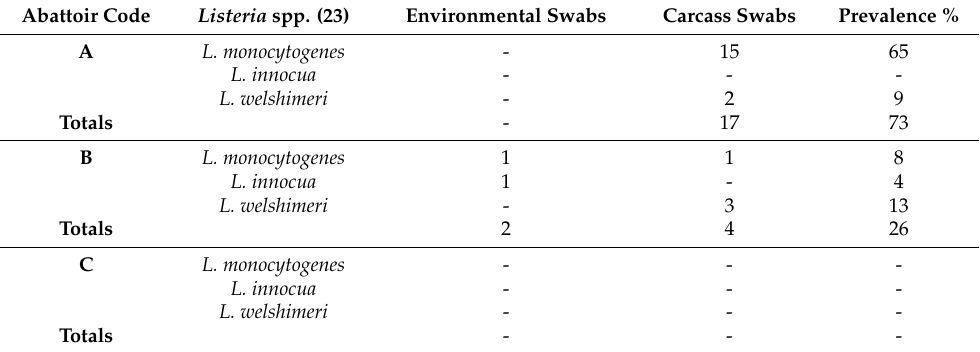
Table 3. Distribution of specific Listeria species across different abattoirs from the carcass and environmental swabs ( n = 23). Abattoir Code Listeria spp. (23) Environmental Swabs